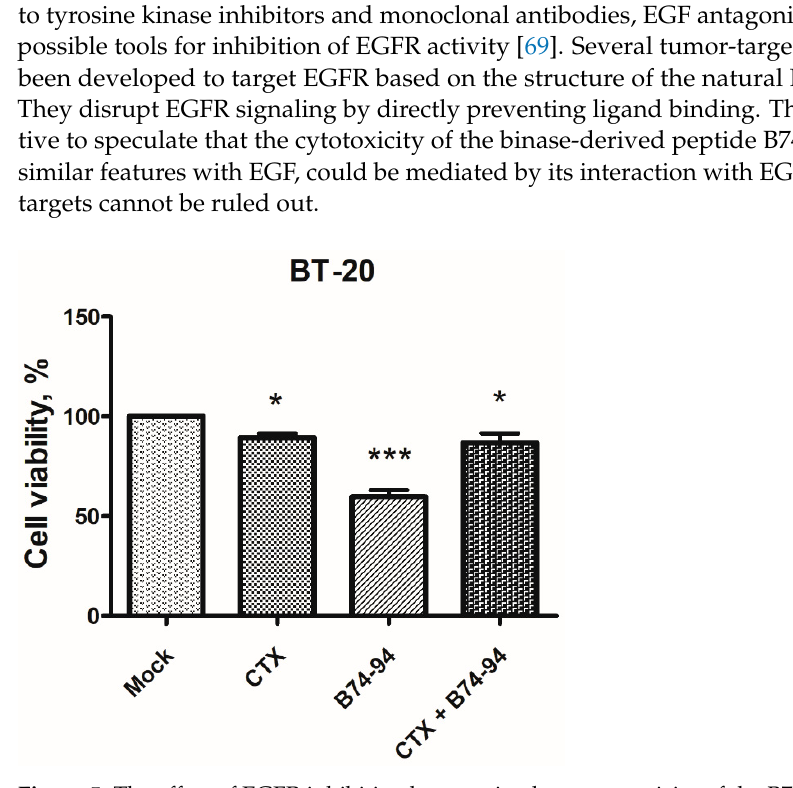
Figure 5. The effect of EGFR inhibition by cetuximab on cytotoxicity of the B74–94 peptide toward BT-20 cells as measured via the MTT assay. The viability of untreated cells was taken for 100%. Data are representative of three independent experiments; * p < 0.05, *** p < 0.001 as determined by two-way ANOVA with Dunnett’s post-hoc test for multiple comparisons.